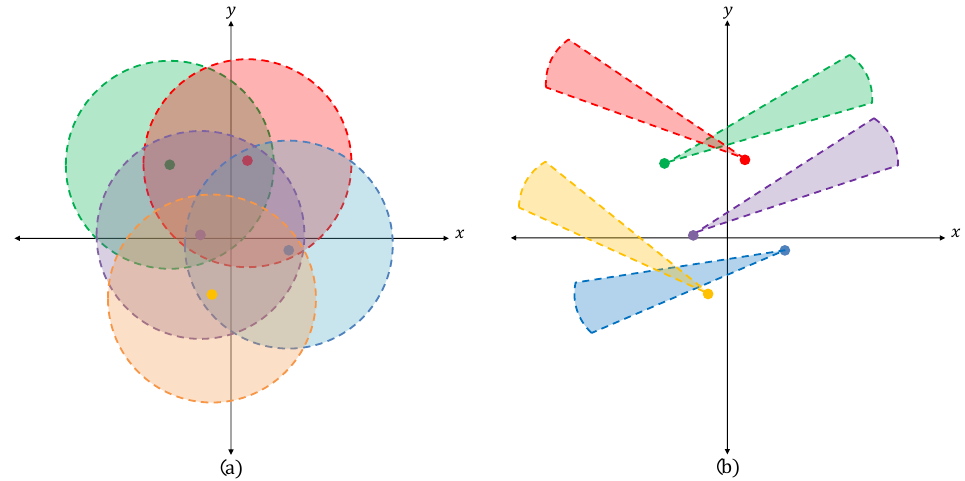
Figure 1. The scenario that sensors (colored dots) have ( a ) omnidirectional or ( b ) directional radiators.